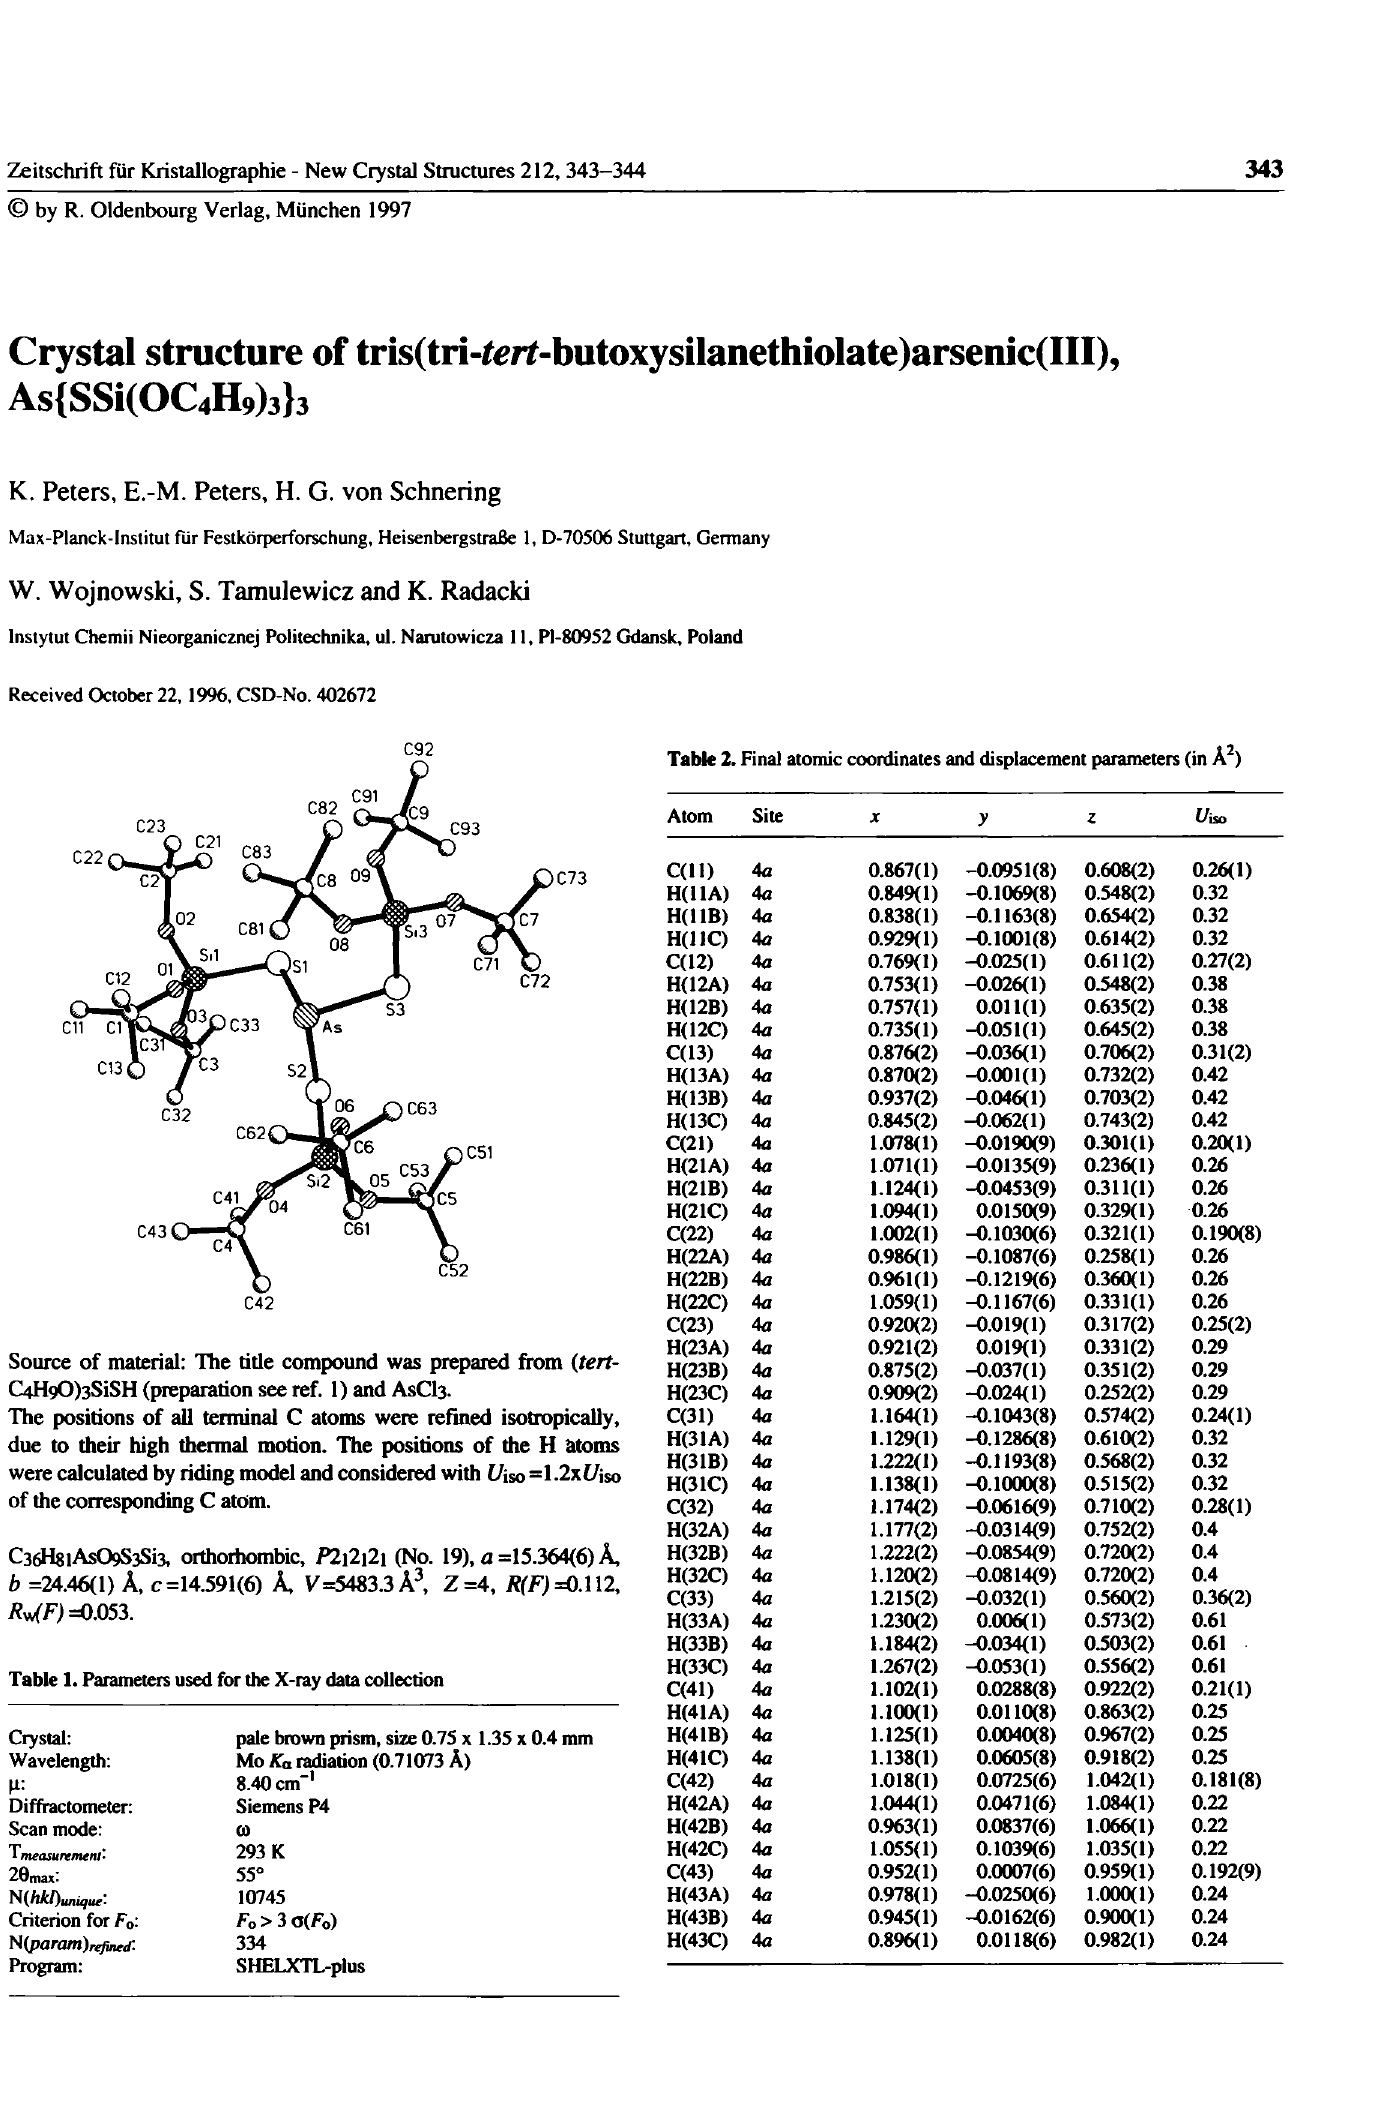
Table 2. Final atomic coordinates and displacement parameters (in A 2